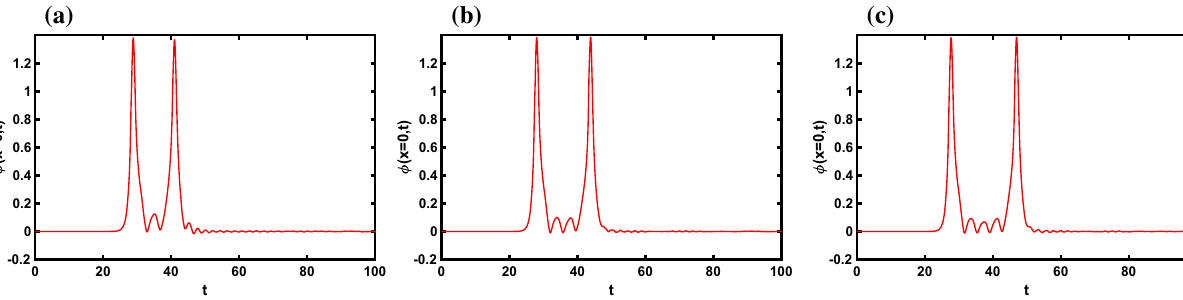
windows being pushed to larger velocities for larger values of n (compare the Fig. 18c,